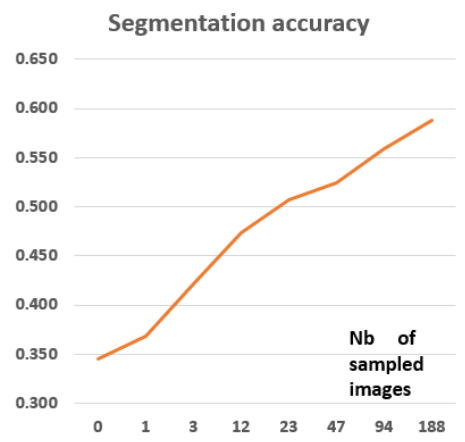
Figure 12. Segmentation accuracy for different numbers of sampled images from the target